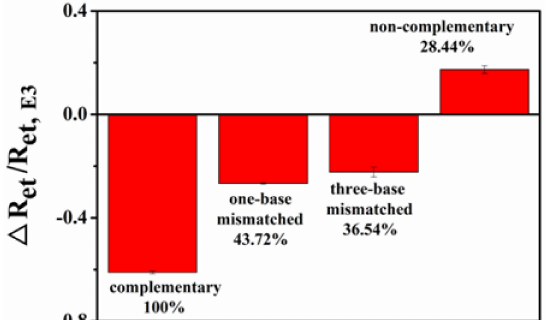
Figure 4. Histogram comparing hybridization signal intensities after detection of 2 µ M of perfectly matched target DNA, and one-base mismatched, three-base mismatched and non-complementary target DNA. Measurements were conducted in 0.05 M Tris-HCl buffer solution (pH 7.40) containing 0.005 M [Fe(CN) 6 ] 3 − /4 − and 0.20 M